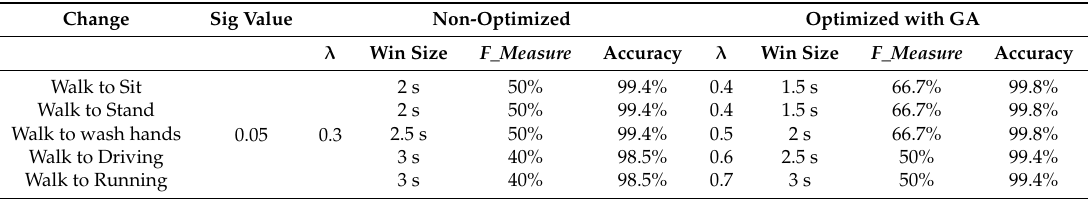
Table 2. Non optimized and optimized with GA parameter set for five different activities on a real